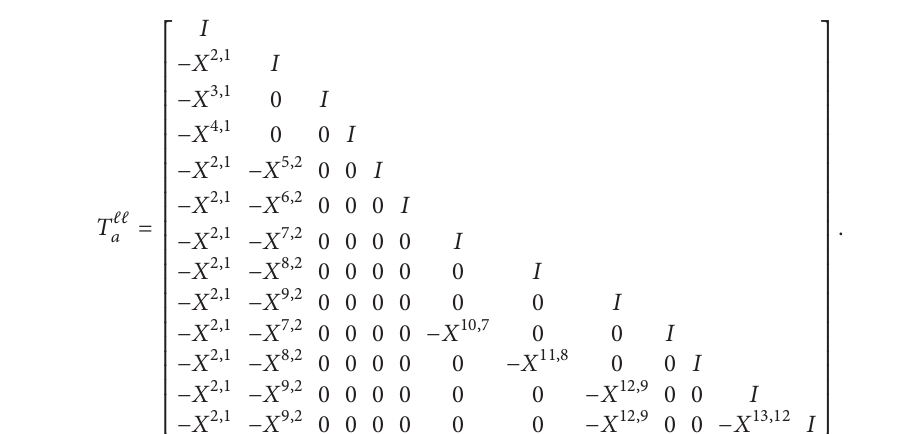
To demonstrate the completeness of the proposed approach a full machine with closed kinematic loops will be presented in the following example. Forestry equipment is typically required to work on different terrains